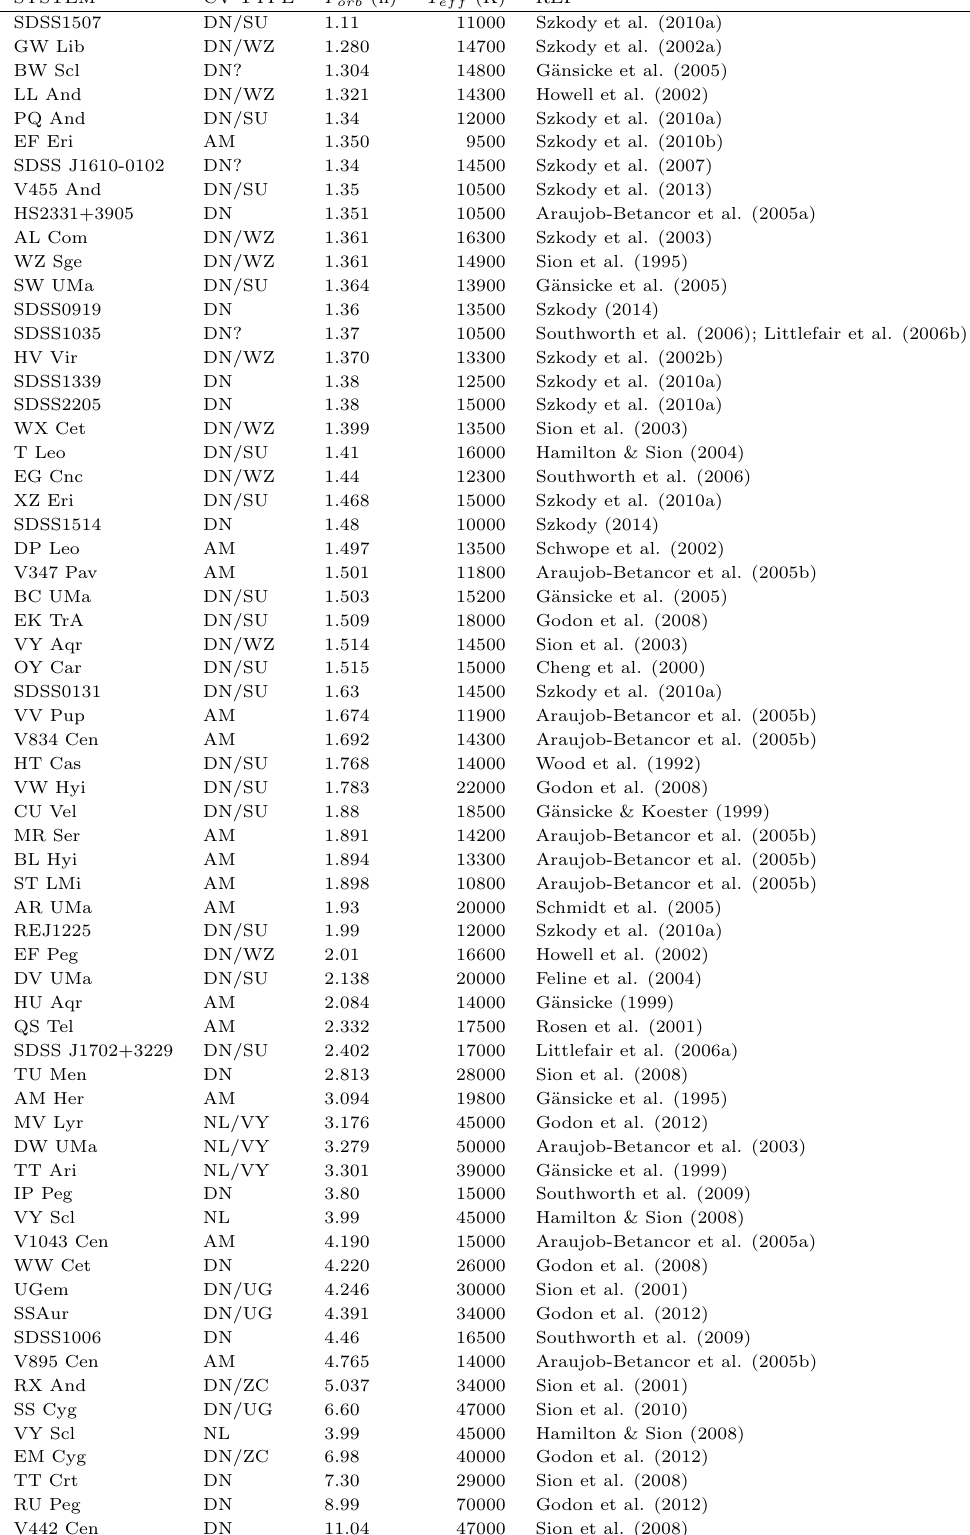
Table 1: The temperature of CV white dwarfs